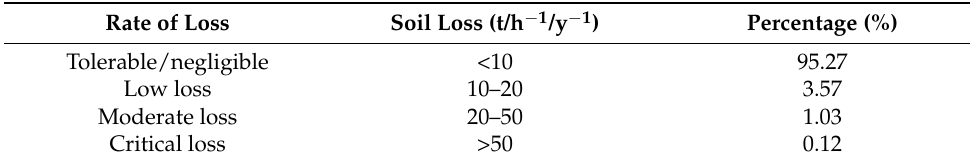
Table 2. An estimation of the annual soil loss rating.